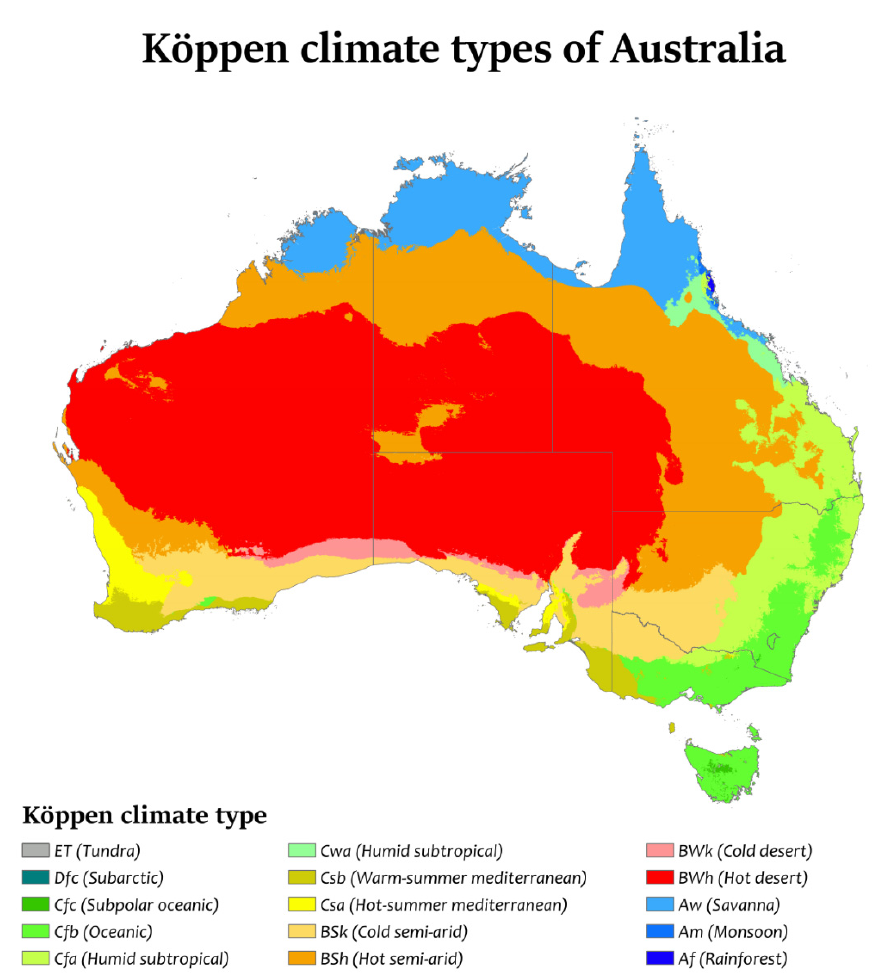
Figure 3. Köppen–Geiger climate classification zone map for Australia [39] (Adam Peterson, Aus- tralian Koppen.svg. Created 13 August 2016. CC BY-SA 4.0. No changes